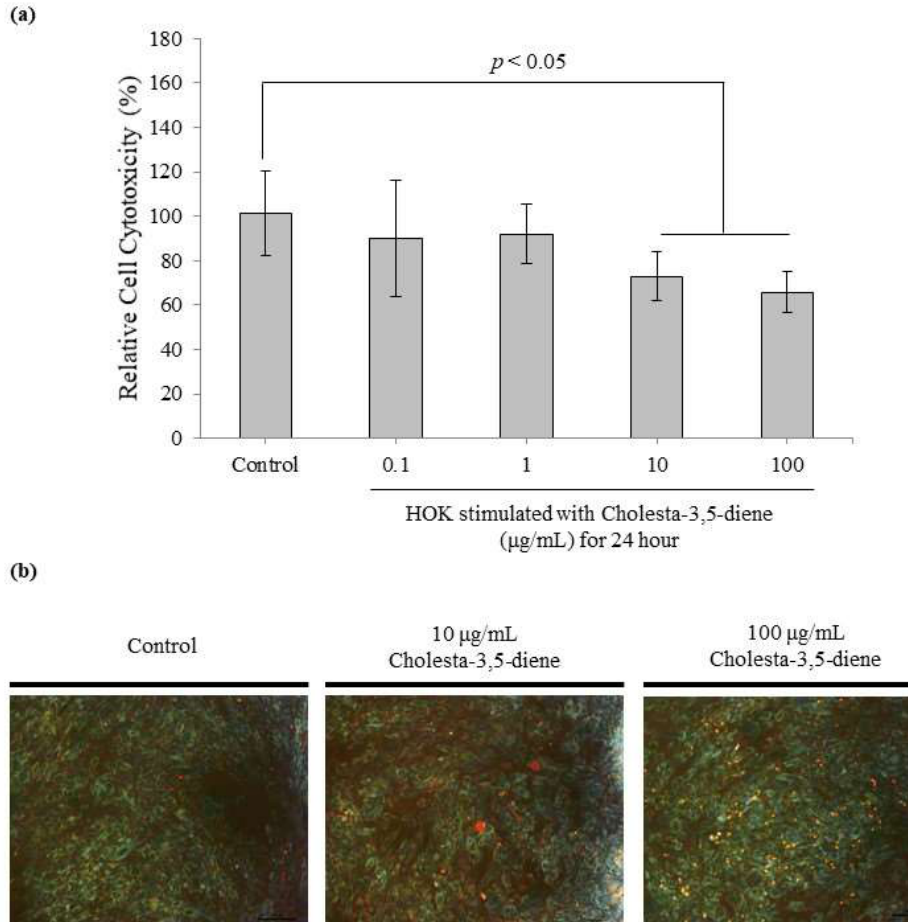
Figure S1: Carbonaceous Thermal Distributions by a laboratory-based thermo-optical ECOC analyzer for the pyrolyzed prostate tissue samples, Figure S2: Mass fragments ( a , b ) of Cholesta-3,5-diene in smoke sample of patient 01 by GC/MS-TD and ( c ) NIST 2008 MS library research result, Table S1: Operational conditions of GCMS-TD system, Table S2: Coefficient of determination (r 2 ) of standards, percent of duplication, and method of detection limit for the target organic compounds in particulate matter, Table S3: Organic carbon (OC) and elemental carbon (EC) concentrations by a laboratory-based thermo-optical ECOC analyzer, Table S4: Concentration of Organic Compounds normalized to PM 2.5 mass in pyrolyzed TURP-smoke by GC/MS-TD, Table S5: Emission Rate of PM2.5 mass in pyrolyzed